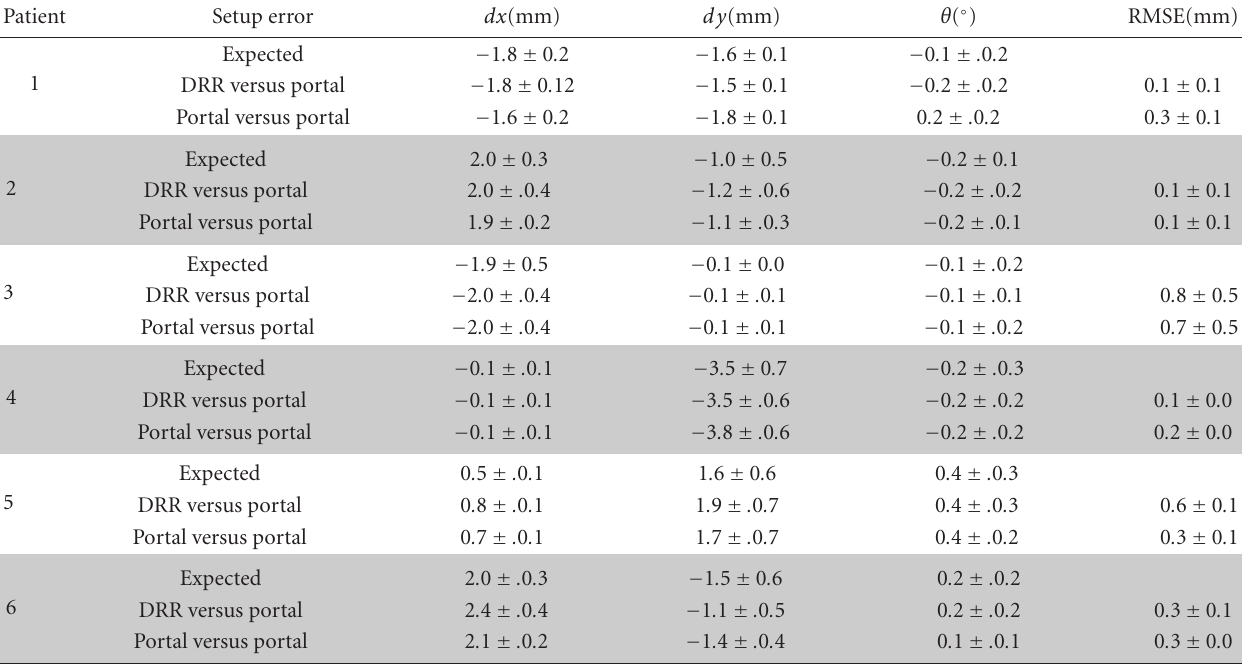
Table 3: Setup error estimations (horizontal displacement, vertical displacement, angle of rotation, and RMS error) for six subjects. The values listed are the mean values ± standard deviation calculated over a set of thirty portal images. The RMSE measurements for portal-portal versus DRR-portal did not show significant di ff erences ( P > 0 . 05, Wilcoxon signed test).